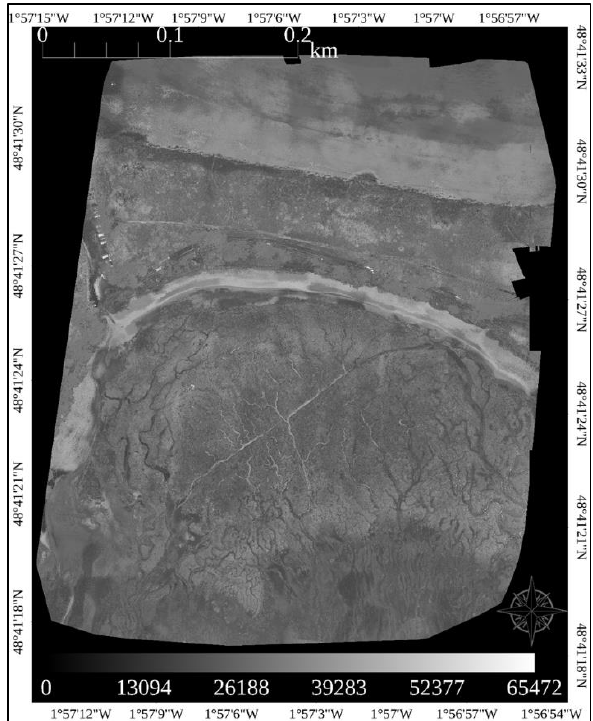
Figure 8 . Infrared reflectance orthomosaic (7132 × 8974 pixels) modelled by the ten-nodded two-layered neural networks based on red-green-blue digital number